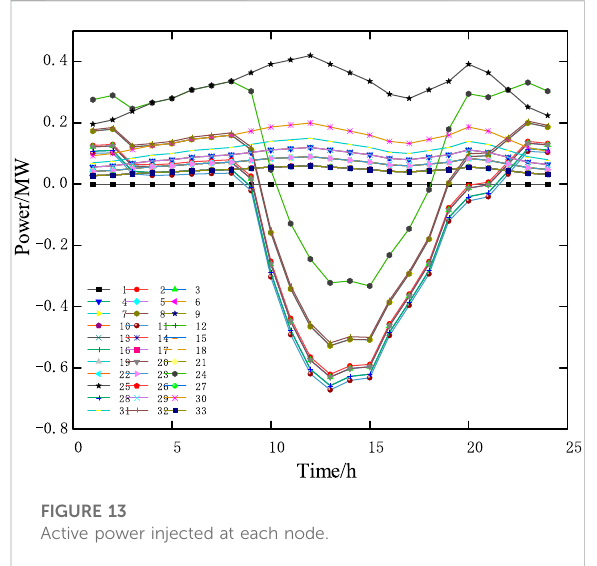
FIGURE 13 Active power injected at each node.